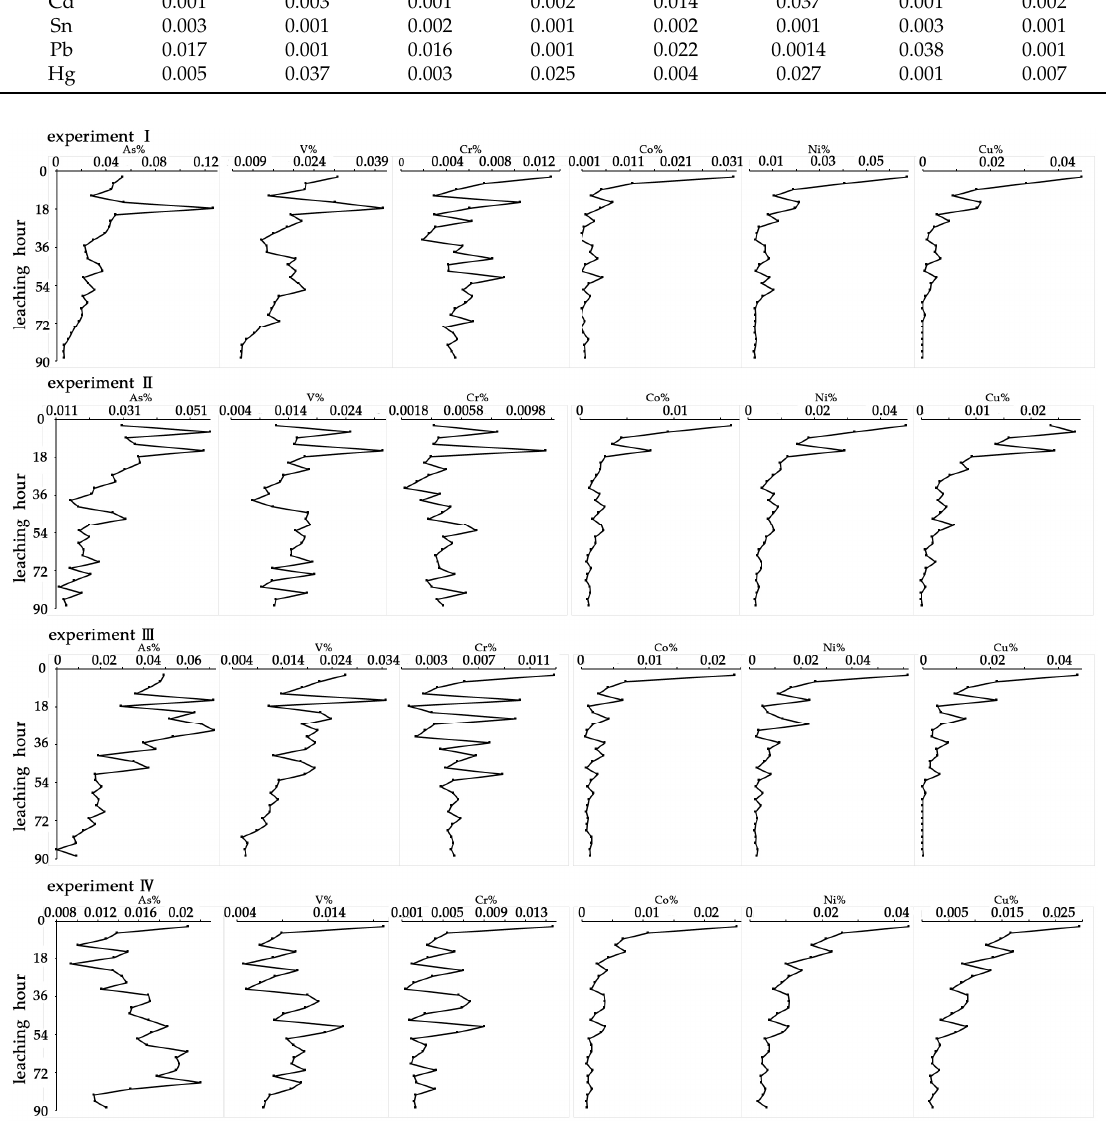
Figure 4. Leachabilities (%) of the elements As, V, Cr, Co, Ni and Cu from the coal gangue over 90 h in the four experiments.